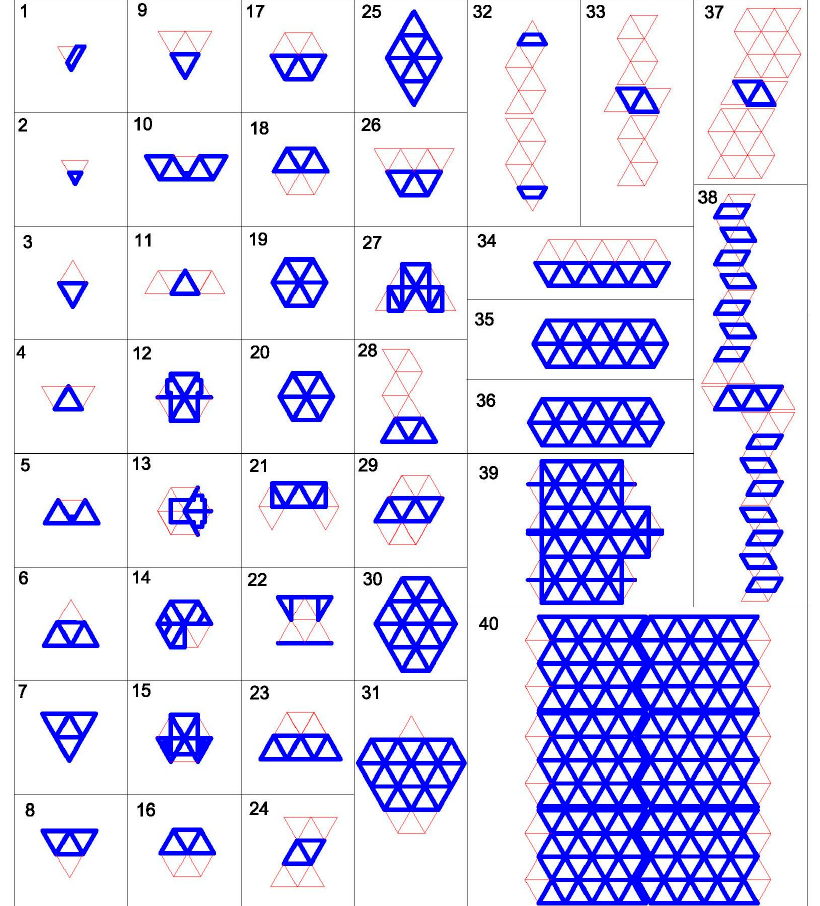
Figure 3. Modular buildings—layout schemes: 1—public transport stop; 2, 9, 26, 28—car